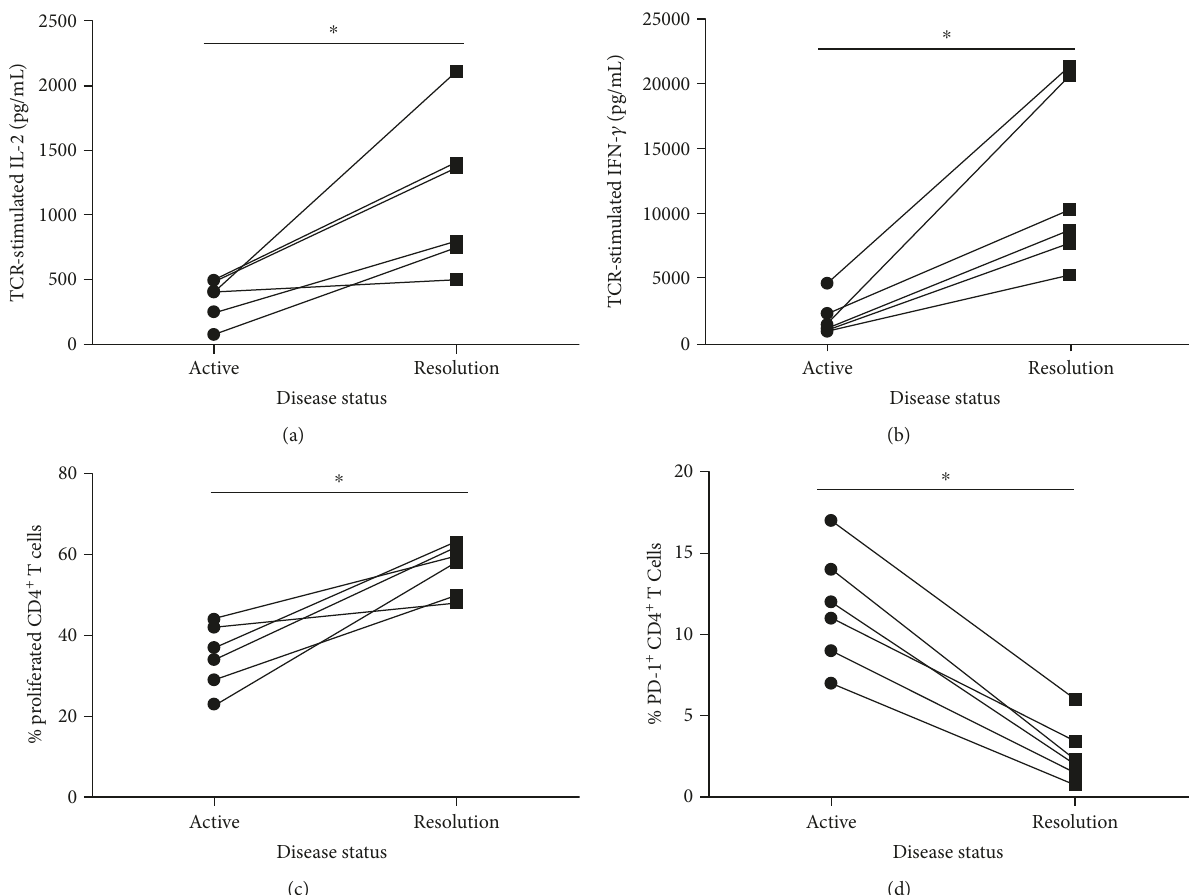
Figure 7: Longitudinal data of sarcoidosis immune function during active disease versus resolution. CD4 + T cells from sarcoidosis subjects that had resolved their disease while participating in our study were analyzed for parameters associated with T cell exhaustion during active disease and during disease resolution. Statistical analysis was performed using the Wilcoxon matched-pairs signed-rank test. ∗ p < 0 05 . (a) TCR-stimulated IL-2 secretion in pg/mL. (b) TCR-stimulated IFN- γ secretion in pg/mL. (c) Percent proliferated CD4 + T cells. (d) Percent PD-1 + CD4 + T